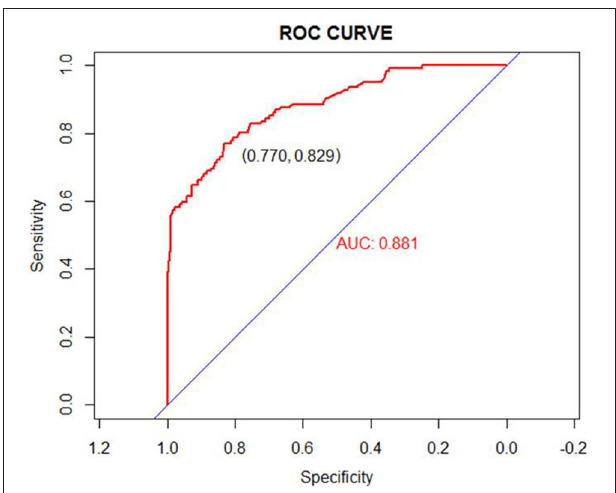
FIGURE 3 | ROC curve for our prediction nomogram model. Area under the ROC curve = 0.881 (ROC, receiver operating curve).